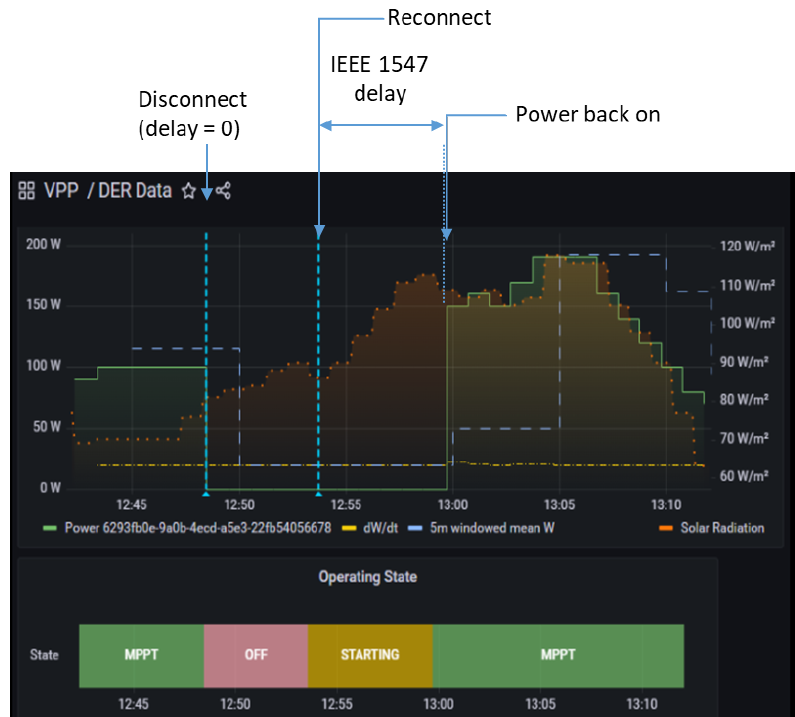
Figure 13. Disconnect/reconnect functionality, displayed using Grafana